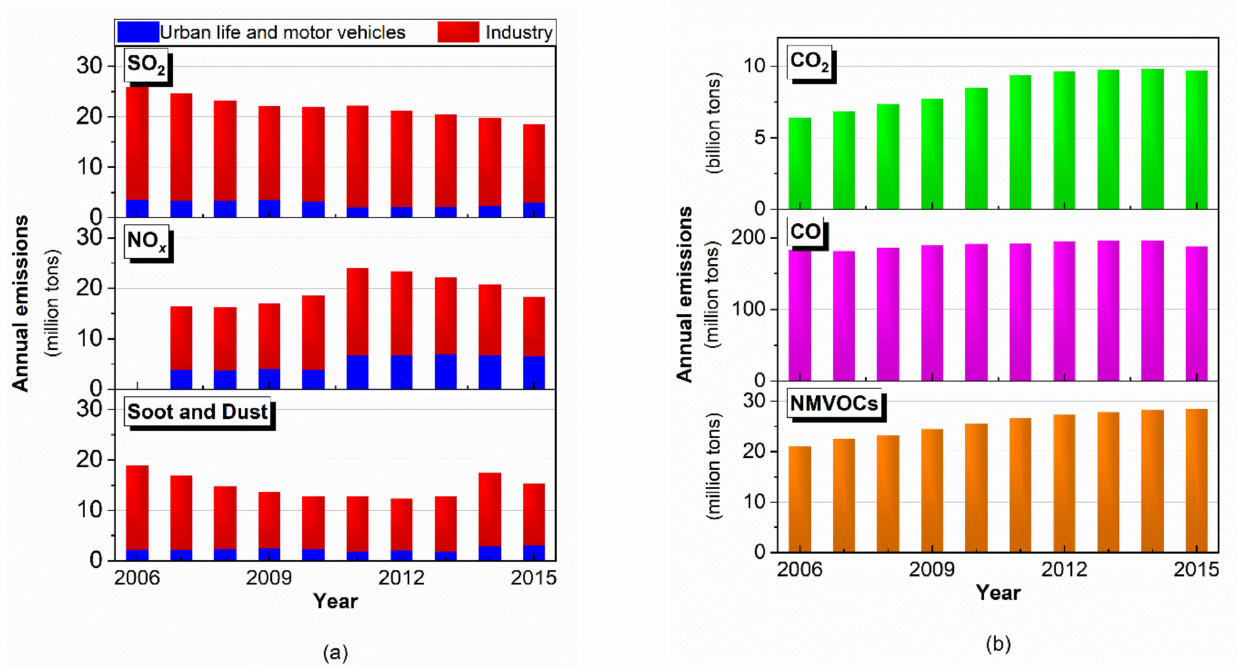
Figure 1. Various pollutant emissions in China from 2006 to 2015 [8–10]. ( a ) the annual emissions of SO 2 , NO x and soot in china, and ( b ) the annual emissions of CO 2 , CO and NMVOCs in